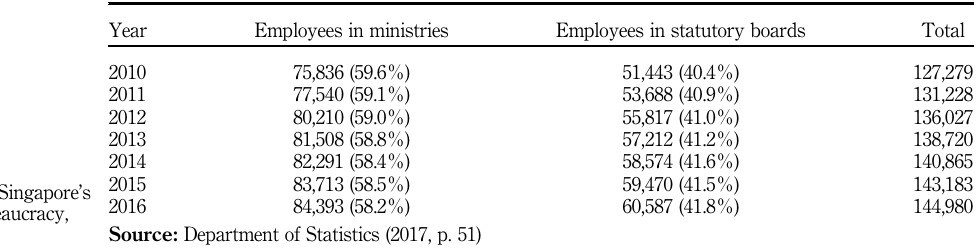
Table II. Growth of Singapore ’ s public bureaucracy, 2010 –